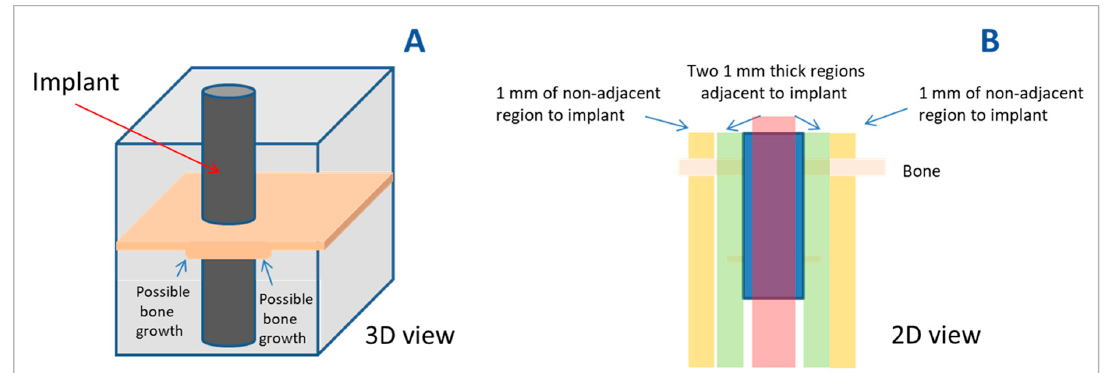
Figure 4. Analysis of bone growth by micro-computed tomography ( μ -CT). Schematic representation of 3D view ( A ) and 2D view ( B ) of the dimensions of the surrounding bone that were analyzed.